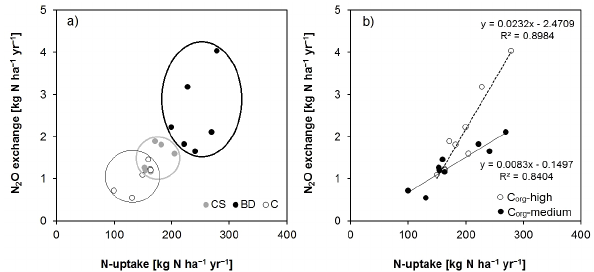
Figure 5. Relationship between cumulative annual N 2 O emissions and annual plant N uptake for the treatments (a) and for the inves- tigated soil types (b) . Dots represent mean annual values of each PVC collar; CS, cattle slurry; BD, biogas digestate; C, control.